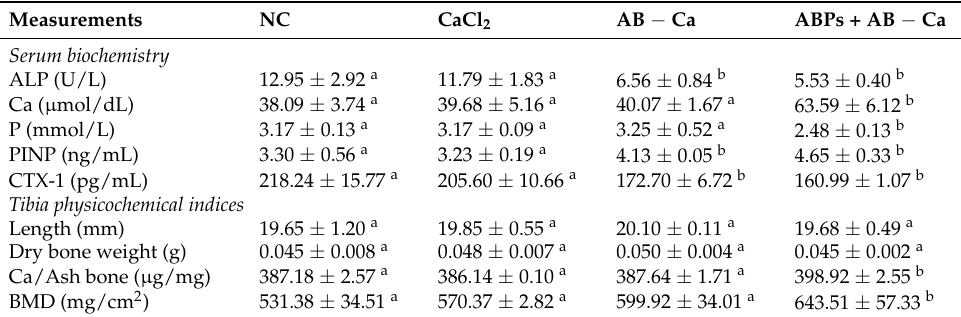
Table 2. Serum biochemistry and tibia physicochemical indices of mice in different